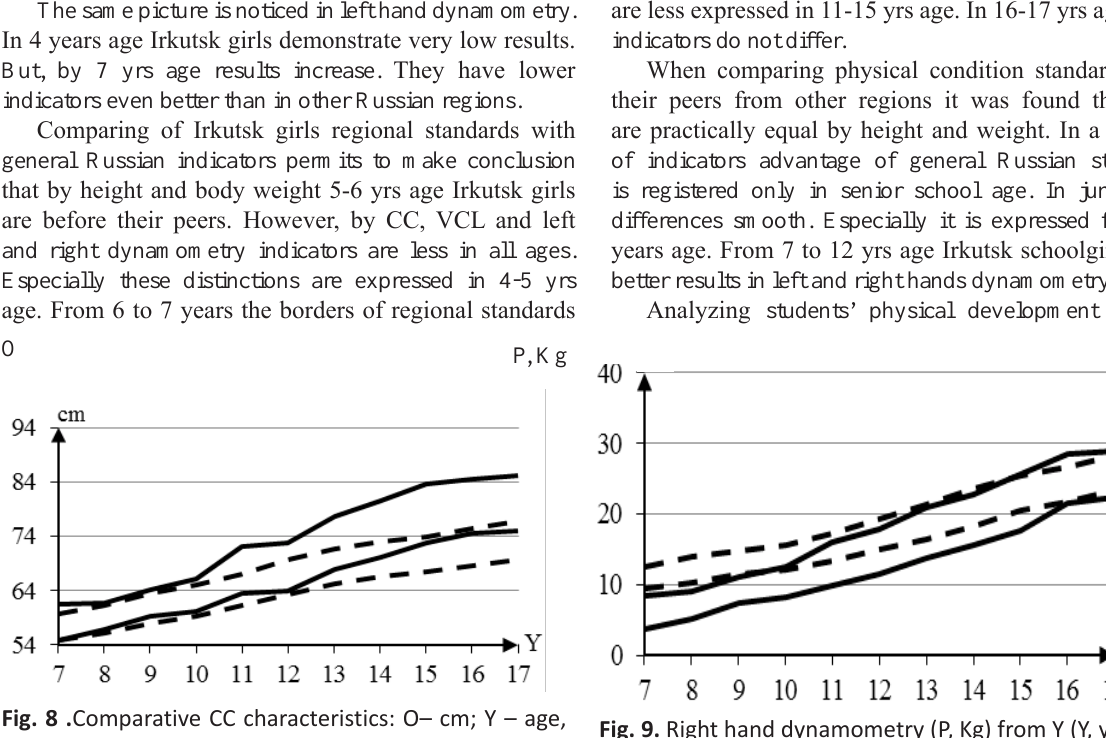
Fig. 9. Right hand dynamometry (P, Kg) from Y (Y, years)